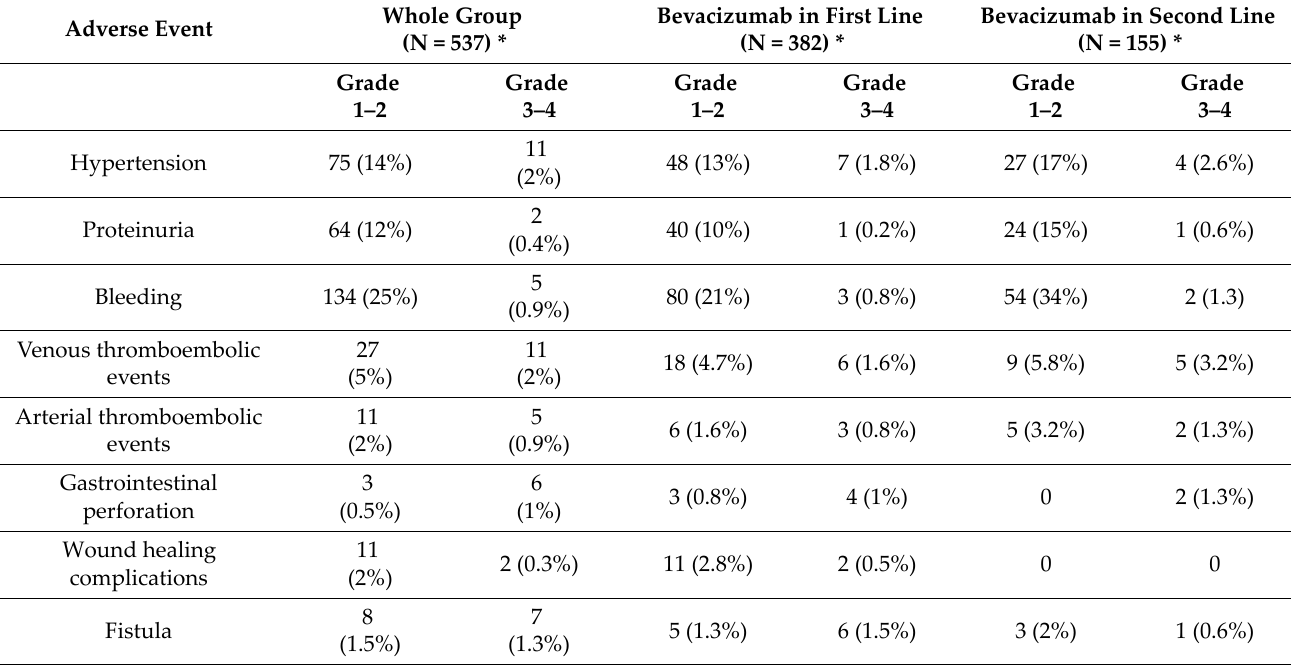
Table 5. Bevacizumab‑related adverse events in the study